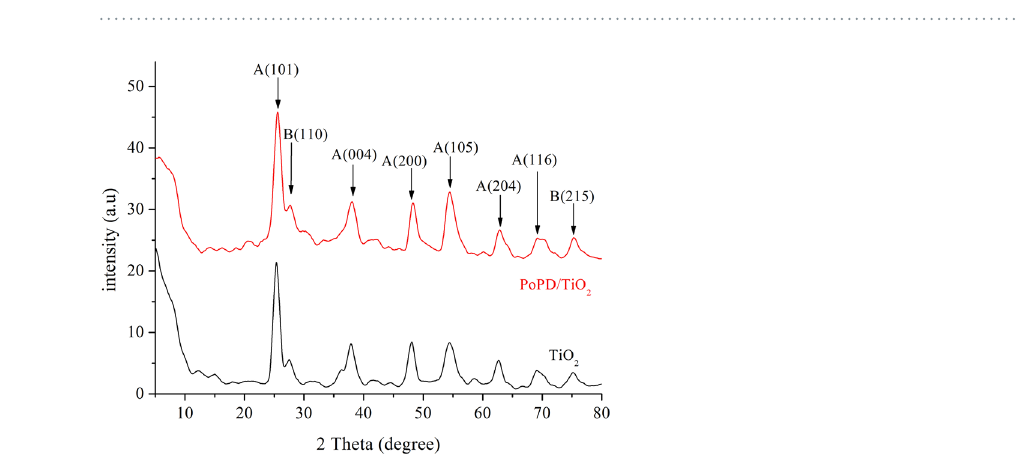
Figure 1. N 2 adsorption and desorption isotherms at 77 K onTiO 2 and P/T(1/4).